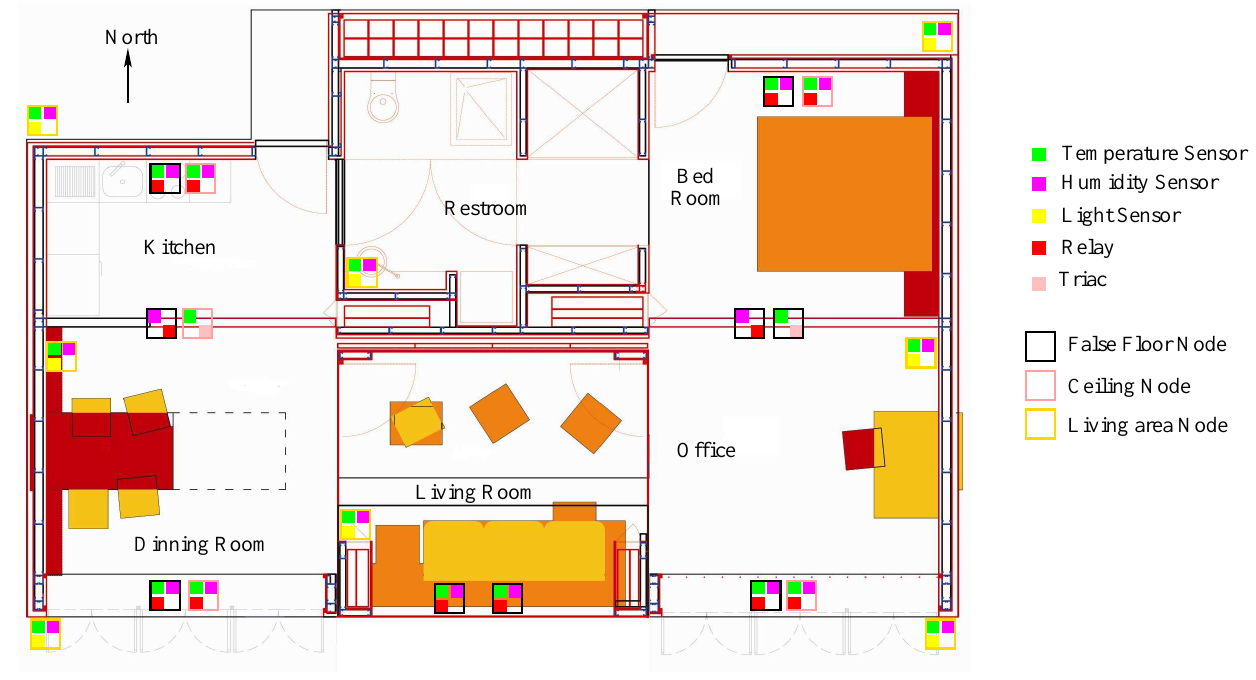
Figure 10. Actual location of nodes and their sensors in the